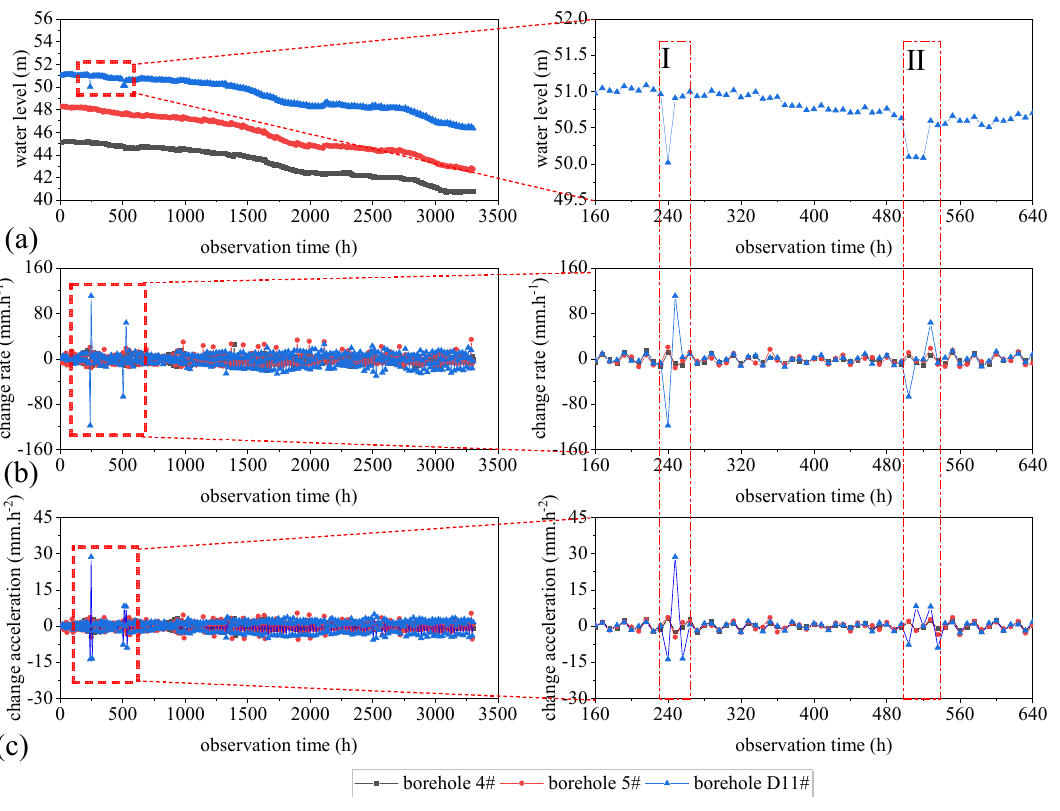
Figure 11. Water level variation in hydrologic holes near the 2129 working face: ( a ) water level; ( b ) change in the water level rate; ( c ) change in the water level acceleration.